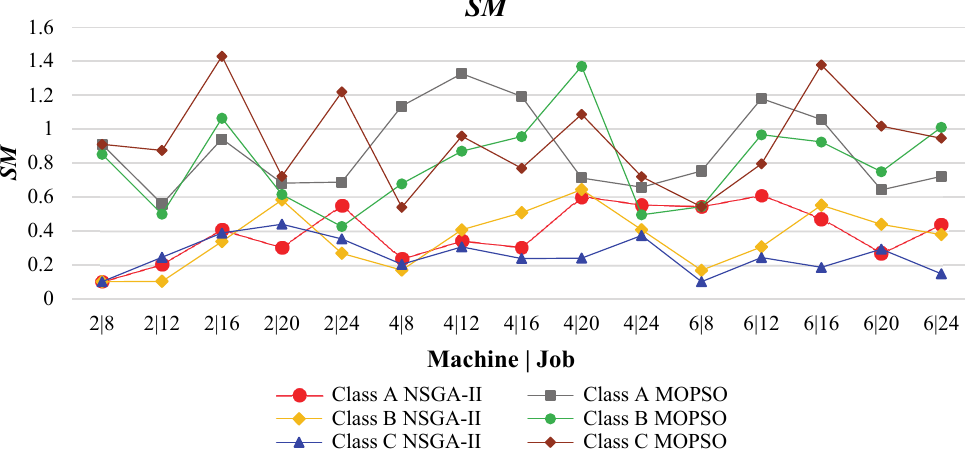
Fig. 10. SM criterion for the two algorithms in the small scale sample